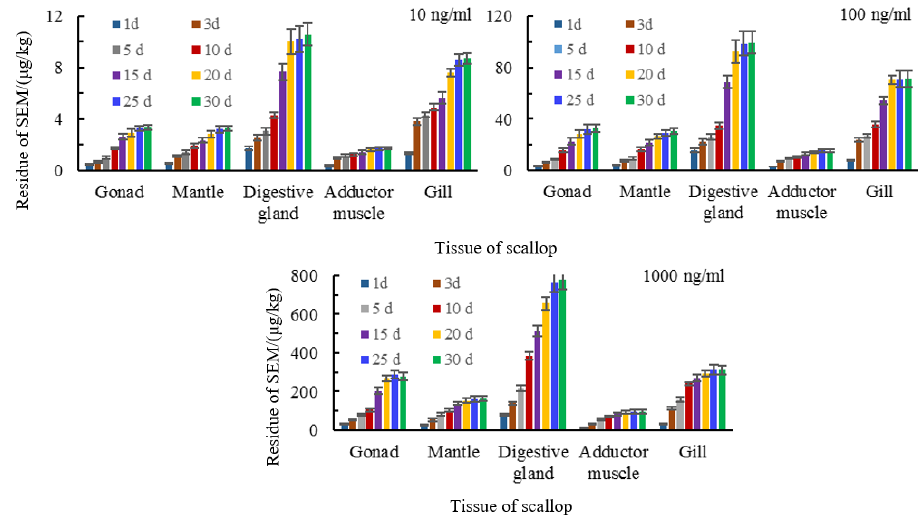
Figure 4. Distribution of tissue-bound semicarbazide in scallop tissues